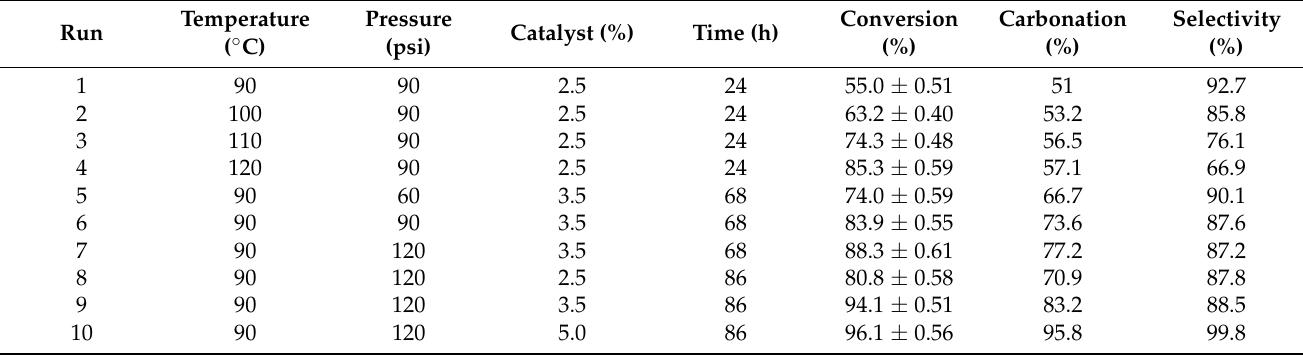
Table 2. Experimental Settings and Average Values of the Reaction Parameters: Conversion, Carbonation and Selectivity Percentages.